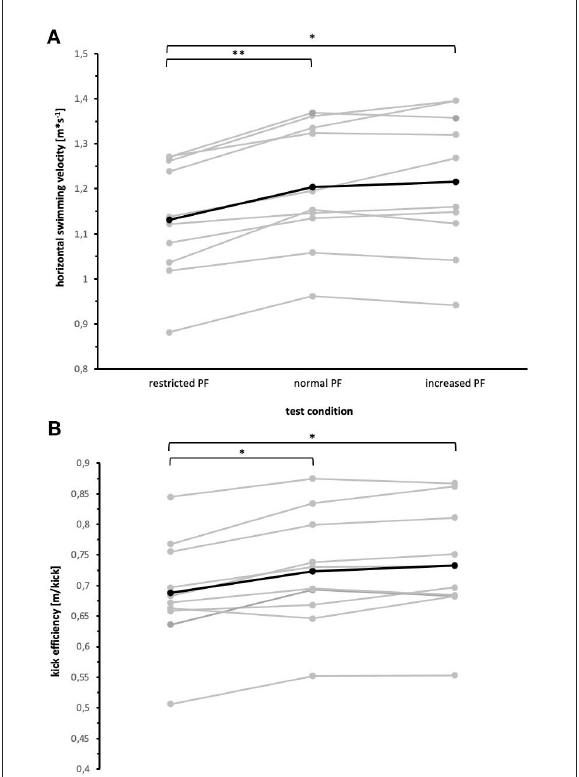
FIGURE2 Effect of increased, normal, and restricted plantar flexion angle on horizontal swimming velocity (A) and kick efficiency (B) . Gray lines represent individual swimmers while the black line represents the mean value. * p < 0.05, ** p <